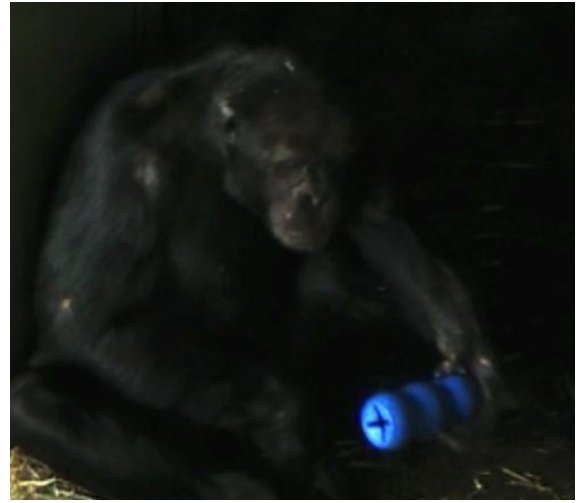
Figure 1. Chimpanzee manipulating a Kong Toy, constituting the outer shell of one of our